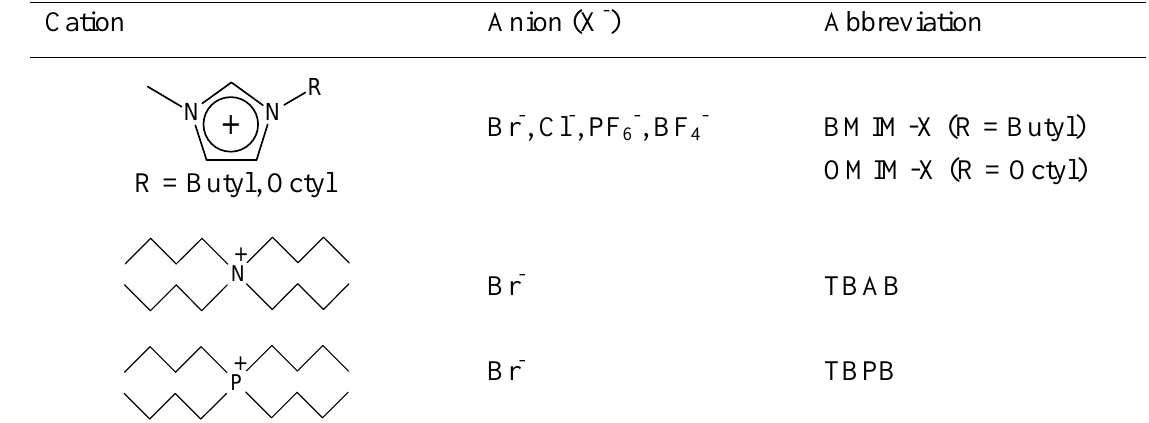
Table 1. Ionic liquids used as catalysts for the synthesis of cyclic urethanes from amino